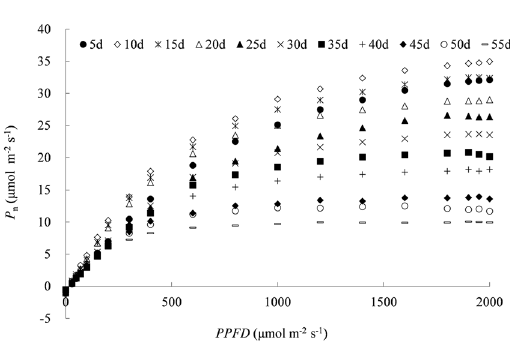
Figure 2. Measured response of net photosynthetic rate ( P n ) for rice leaves at various ages to photosynthetic photon flux density ( PPFD ) ( P n is the average photosynthetic rate for leaf age groups at n day, numbers “ n d” in legend indicates the nominal leaf age for each leaf age group with ± 2 days